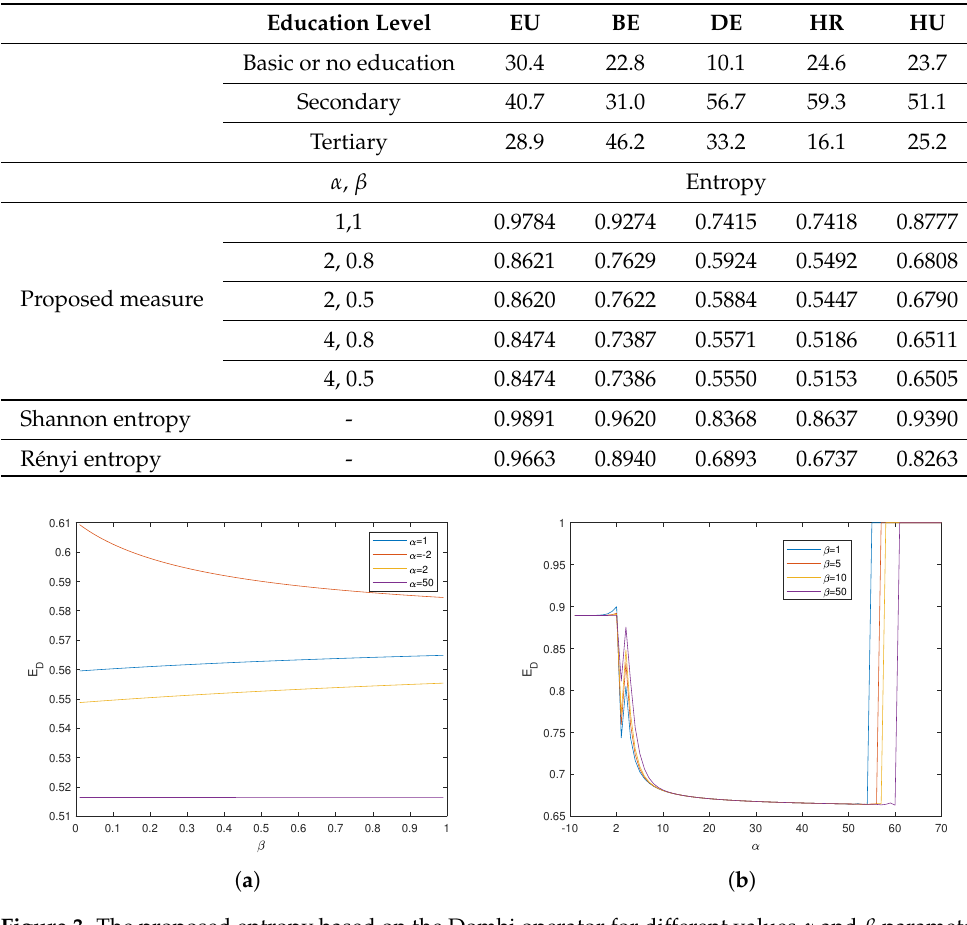
Figure 3. The proposed entropy based on the Dombi operator for different values α and β parametar. ( a ) Values of proposed entropy measure for α = 1, α = − 2, α = 2, and α = 50 with β ranging from 0.1 to 1. ( b ) Values of proposed entropy measure for β = 1, β = 0.8, β = 4, β = 8, and β = 50 with α ranging from − 10 to